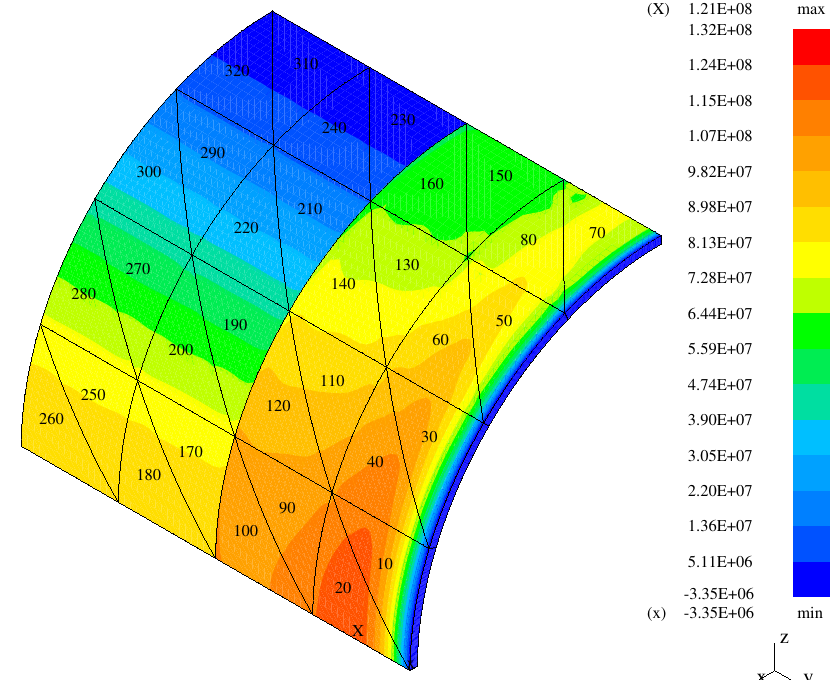
Figure 17. Third normal stress—the membrane with the classical transition